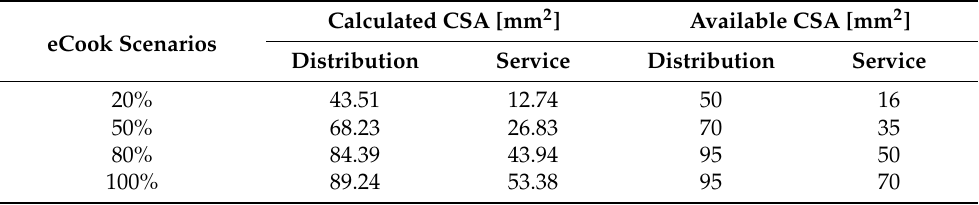
Table 8. Distribution/Service CSA cables for eCook mini-grid penetration